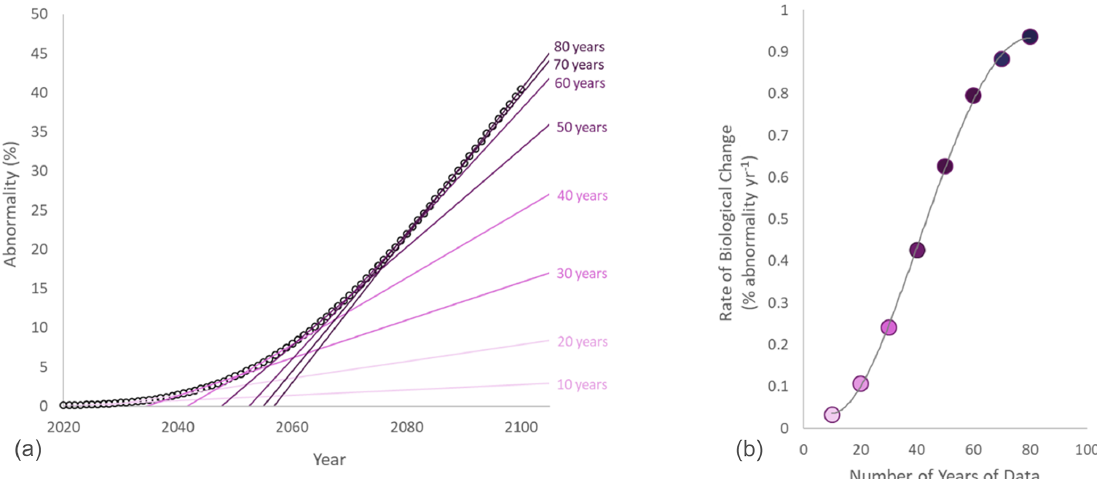
Figure 5. (a) Evaluation of the rate of biological change as the coefficient of the significant regression between time and abnormality over time (after collecting 10 years of data, 20 years of data, etc.). (b) Relationship between the number of years of data for the biological monitoring and the calculated rate of biological